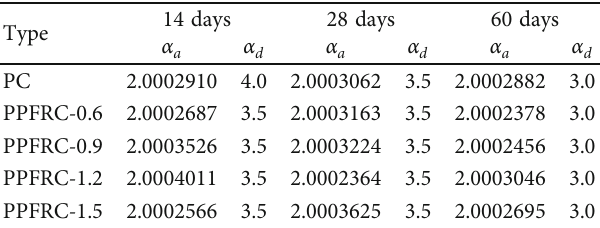
Table 8: Parameter α